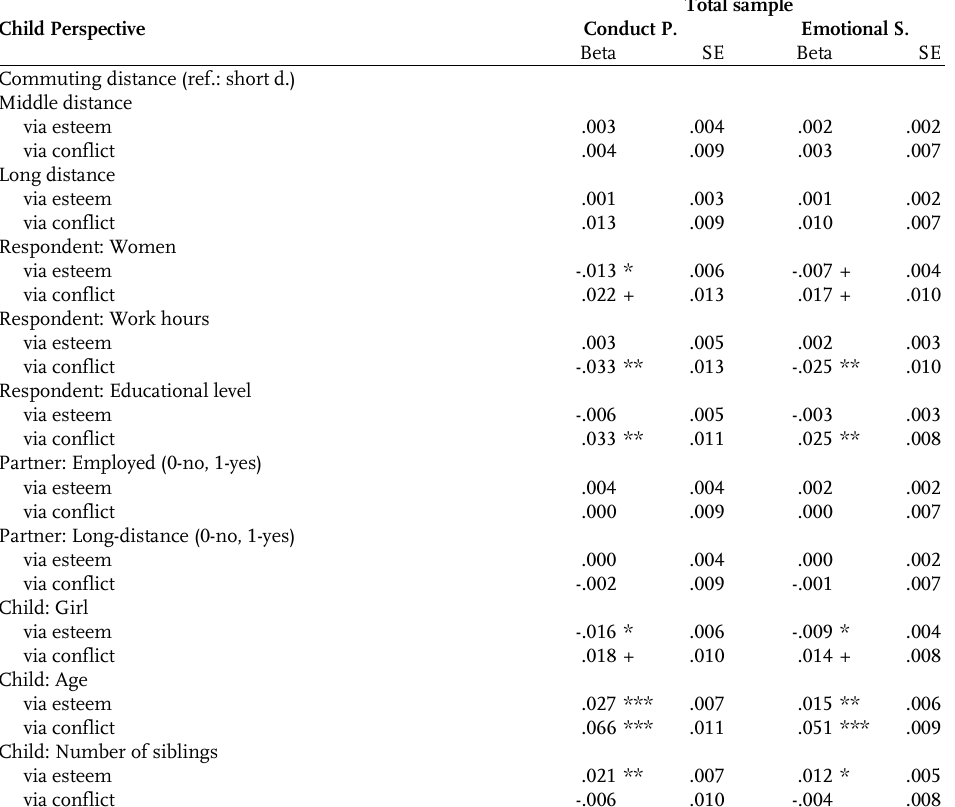
Total sample Beta SE Beta SE